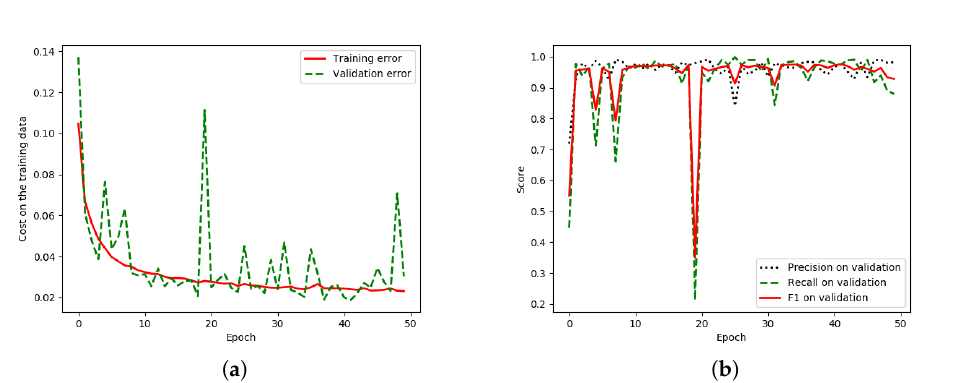
Figure 12. Graph (learning curves) of the Landsat-8w3c data set of the proposed approach, “HR-GCN-FF-DA”; x refers to epochs, and y refers to different measures ( a ) Plot of model loss (cross-entropy) on training and validation corpora; ( b ) performance plot on the validation corpus.